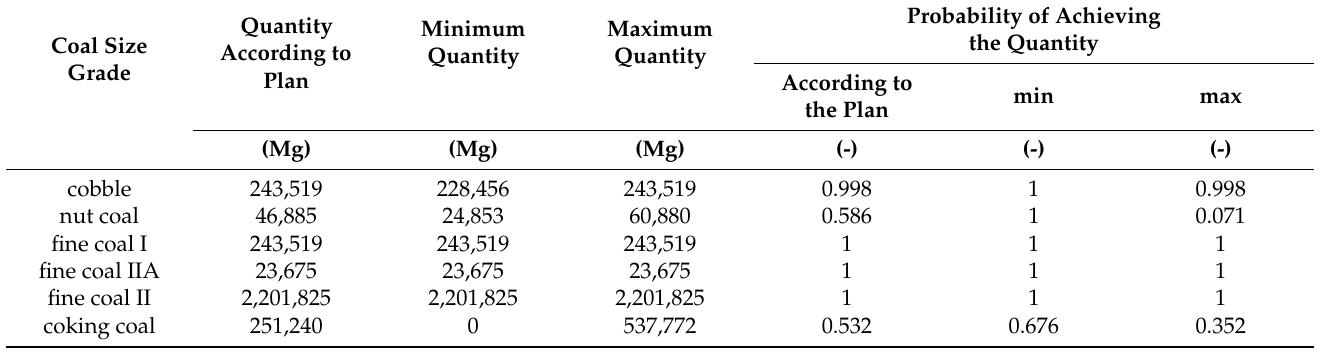
Table 12. A summary of the volumes of sales of the individual coal grades with the probability of their achievement at σ yprog for mine “F”.